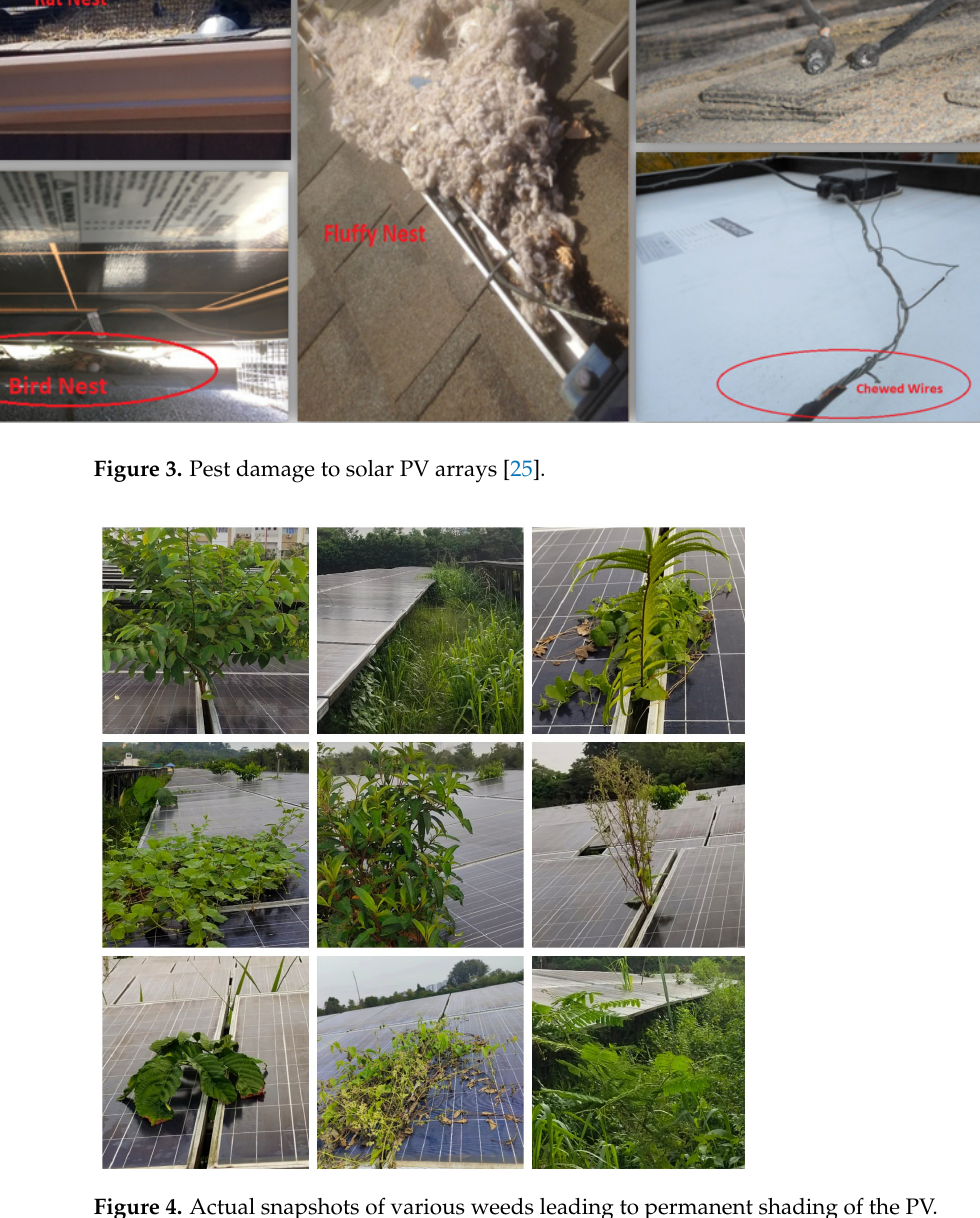
Figure 4. Actual snapshots of various weeds leading to permanent shading of the PV. As shown in Figure 5, the performance of the whole PV panel will be negatively affected even though only a small section of the solar panel is shaded. This is because PV panels are composed of a number of PV cells that are wired in series; that is to say, the power output of the whole system in series is dropped to the level of current passing through the weakest cell when the power output of a single cell is significantly reduced due to weed permanent shading [26]. Beyond that, when a shaded cell generates much less current than the unshaded ones, due to the series connection of the cells in the modules, the same current must flow through all the cells. Therefore, the more serious situation is that the shaded cells can heat up to such extreme temperatures that the PV module can become burnt out and permanently damaged [27]. The arrow in Figure 5 indicates the effects of reduction in current flow due to the partly shaded solar PV Module.